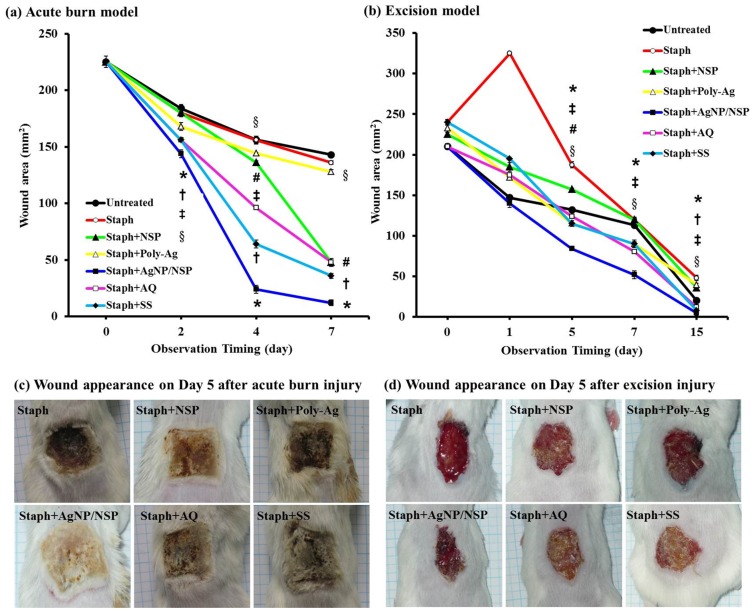
Wound healing rates on (a) acute burn model (b) excision wound model and the photographs of wound appearance on day 5 after (c) acute burn injury and (d) excision injury.The rate of infected wound healing was compared in animals treated with staphylococcus only (Staph), staphylococcus and NSP (Staph+NSP), staphylococcus and Poly-Ag (Staph+Poly-Ag), staphylococcus and AgNP/NSP (Staph+AgNP/NSP), staphylococcus and Aquacel® (Staph+AQ), staphylococcus and silver sulfadiazine (Staph+SS), and control (untreated). The results are expressed as the mean ± SD from three independent experiments in each group. *P<0.05, comparison between AgNP/NSP and the other 6 groups at each time point; † P<0.05, comparison between SS treatment with the untreated, Staph, Staph+NSP, and Staph+Poly-Ag groups; ‡ P<0.05, comparison between AQ treatment with the untreated, Staph, Staph+NSP, and Staph+Poly-Ag groups; # P<0.05, comparison between NSP treatment with untreated, Staph and Staph+Poly-Ag groups; § P<0.05, comparison between Poly-Ag treatment with untreated and Staph groups. All the comparisons were confirmed by Student’s t test.